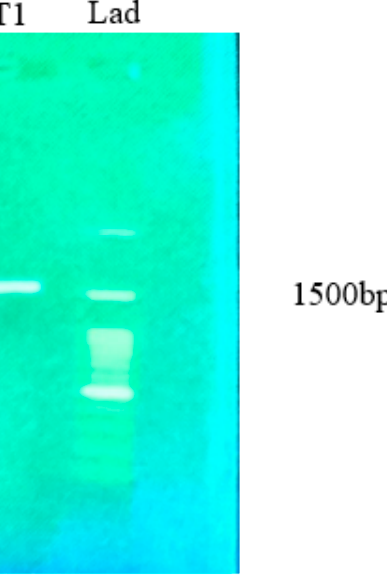
Figure 2. Identification of 16S rRNA gene bands of enzyme-producing bacteria with a molecular weight of 1500 bp; Lad is a molecular marker.